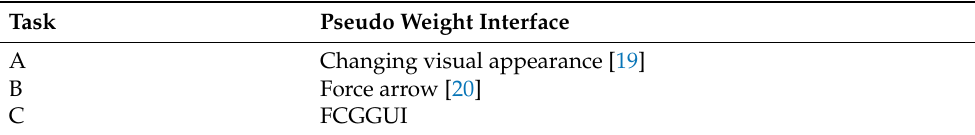
Table 2. Group of tasks.